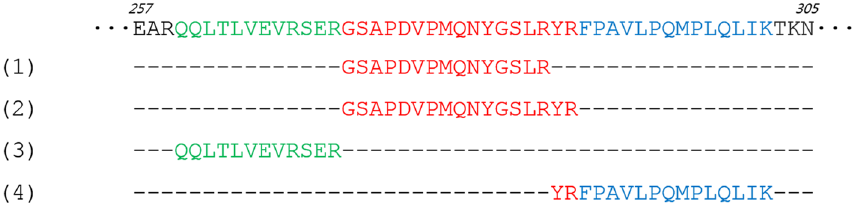
Figure 4. Portion of sequence of chicken vitellogenin-2 (P02845). The numbers on top of the sequence indicate the start and end positions of the shown peptide. The detection of only the tryptic peptides (1) and (2), in red, is not sufficient for protein identification, since the amino acidic sequence of peptide (1) is covered entirely by peptide (2). Peptides (1), (3), and (4) are non-overlapping, and therefore can be used to identify the protein. Peptides (2), (3), and (4) can be used for protein identification despite the partial overlapping of peptides (2) and (4), since neither entirely covers the sequence of the